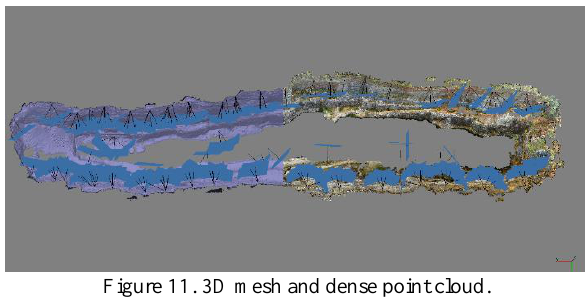
Figure 11. 3D mesh and dense point cloud.